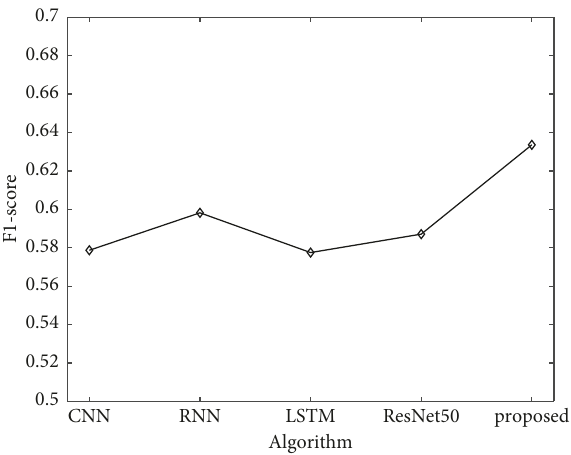
Figure 10: F1-score value of each model. Table 10: The influence of each feature on the model used.